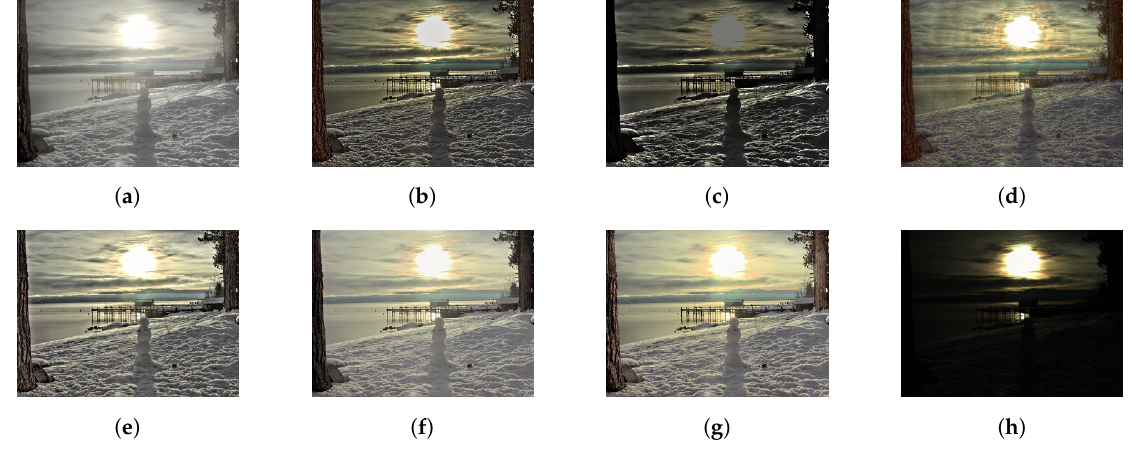
Figure 10. Comparison of tone-mapping methods. ( a ) LW [12], ( b ) WLS [28], ( c ) RoG [2], ( d ) L0 [50], ( e ) IRD [1], ( f ) L0–L1 [29], ( g ) Proposed study, ( h )